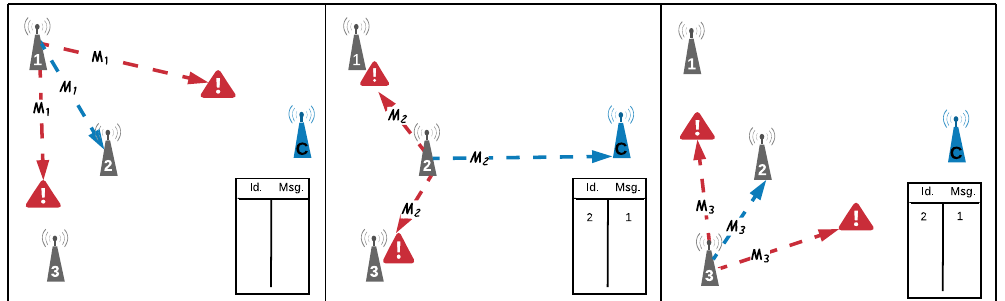
Figure 5. Transmission